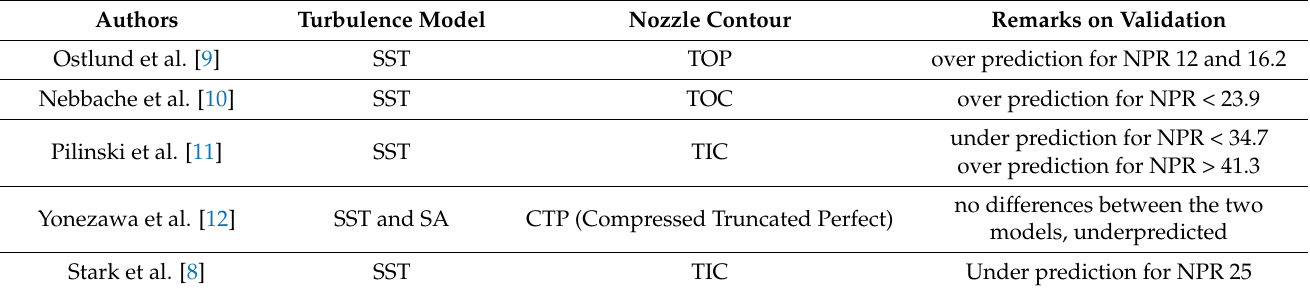
Table 1. Studies on Numerical simulation of flow separation and wall